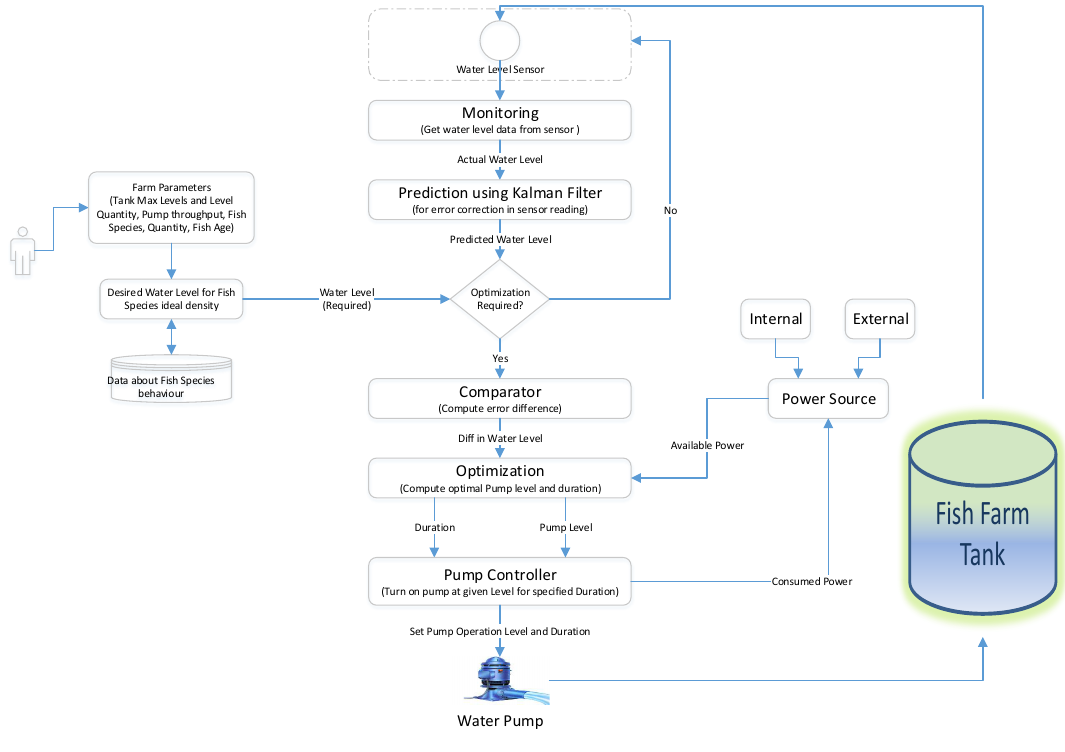
Figure 3. System flow diagram for fish farm water level maintenance with variable pump